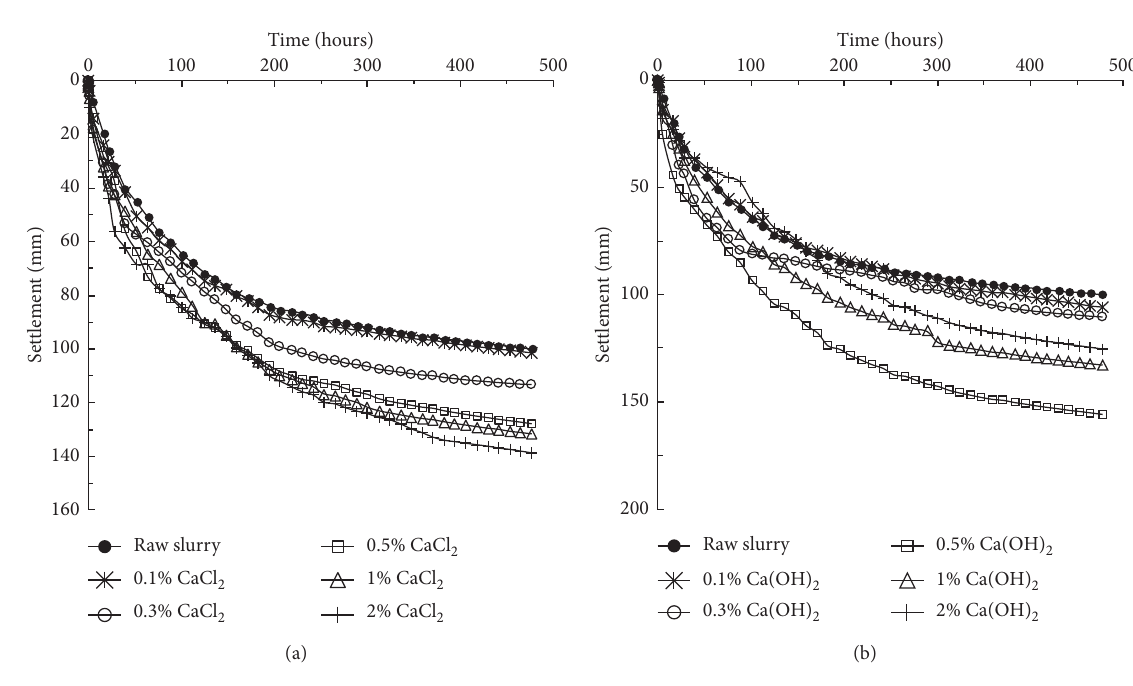
Figure 8: Settlement versus